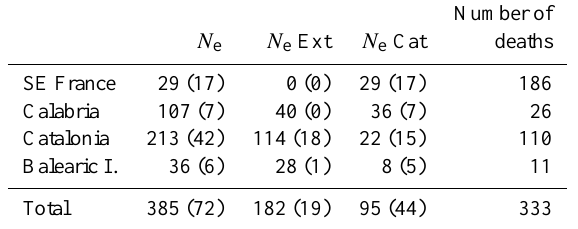
Table 6. Number of events that produced floods(N e ) identified in the FLOODHYMEX database; N e Ext (number of extraordinary flood events); N e Cat (number of catastrophic flood events); and to- tal number of deaths. The period analysed is 1981–2010. Between brackets is the number of events which caused